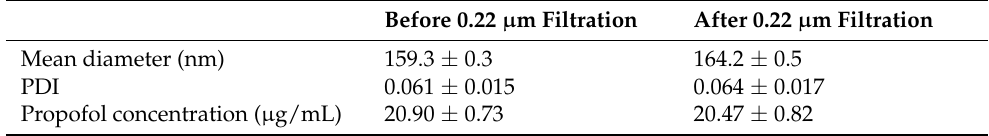
Table 9. Granulometric characteristics and propofol concentration before and after 0.22 µ m